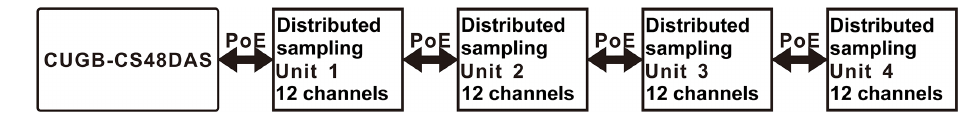
Figure 7. Distributed and centralized seismograph.